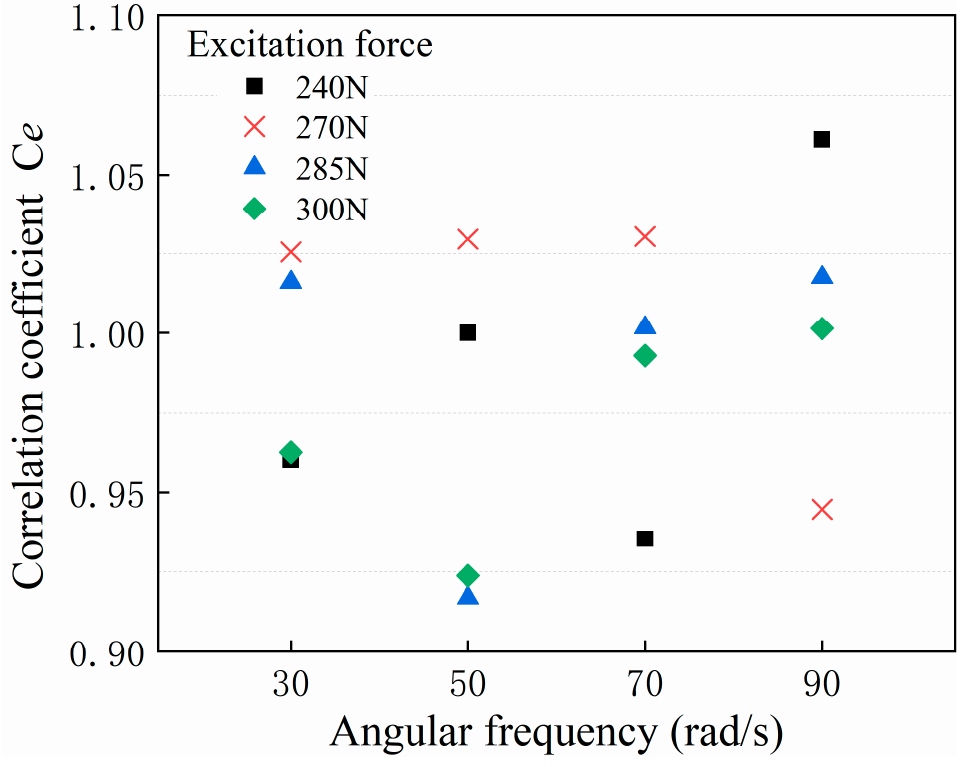
Figure 17. Correlation coefficient C e .